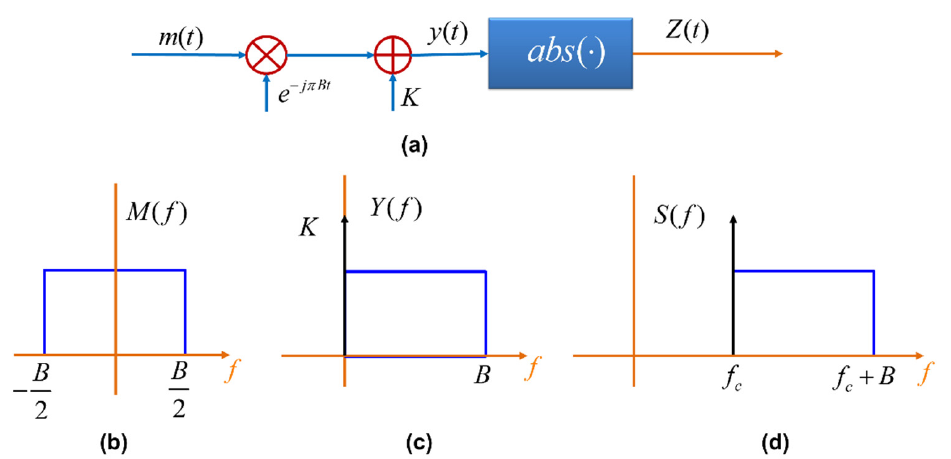
Figure 2. ( a ) Schematic of the KK digital transmitter, ( b ) message spectrum, ( c ) spectrum of y(t) , and ( d ) spectrum of optical transmitter output, i.e., after optical modulation.